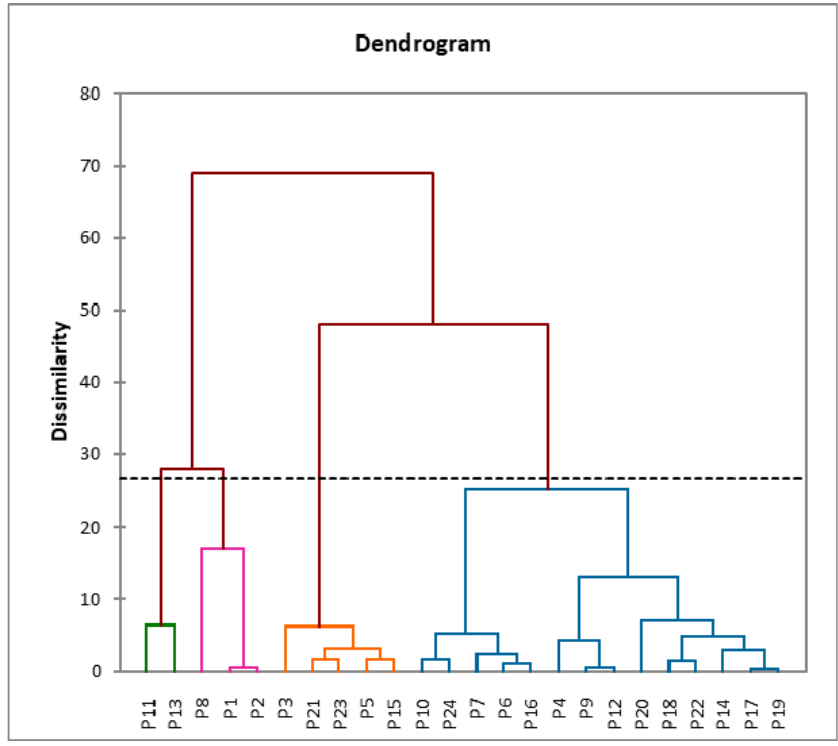
Figure 6. Dendrogram for agglomerative hierarchical clustering.